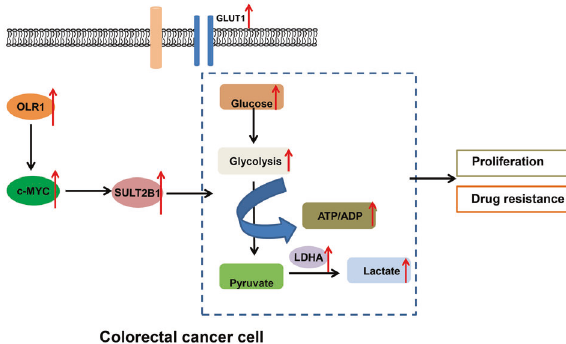
Fig. 8 Mechanism graph of the regulatory network and function of OLR1 . OLR1 promotes colon cancer cell proliferation and chemoresistance by regulating c-MYC/SULT2B1 axis to enhance glycolysis